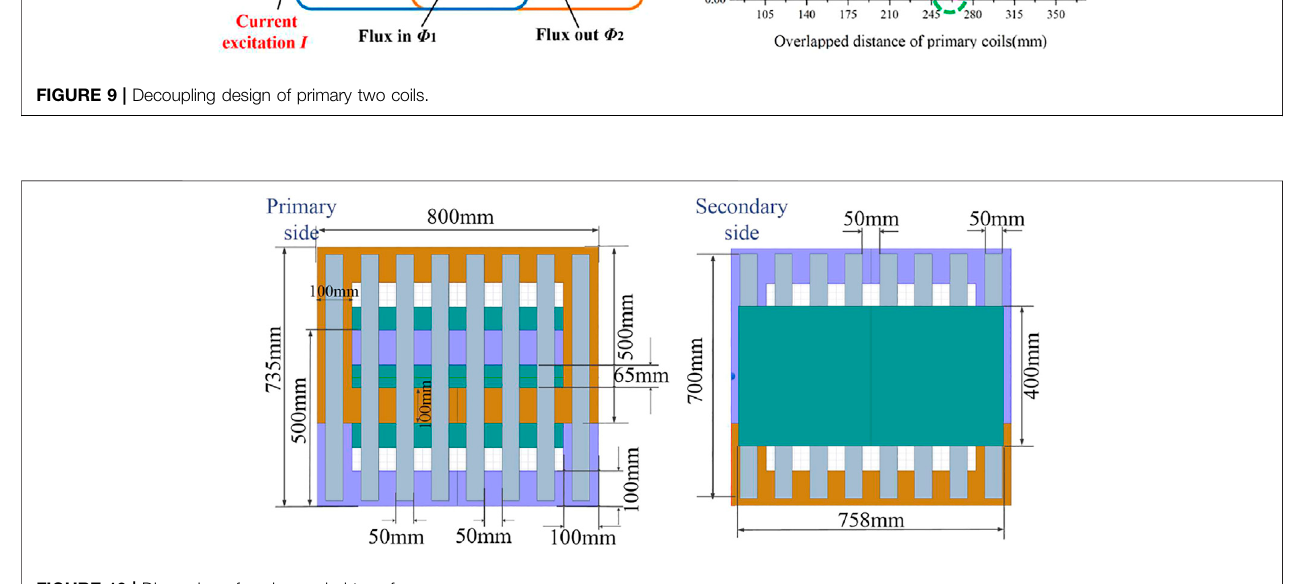
FIGURE 10 | Dimension of each coupled